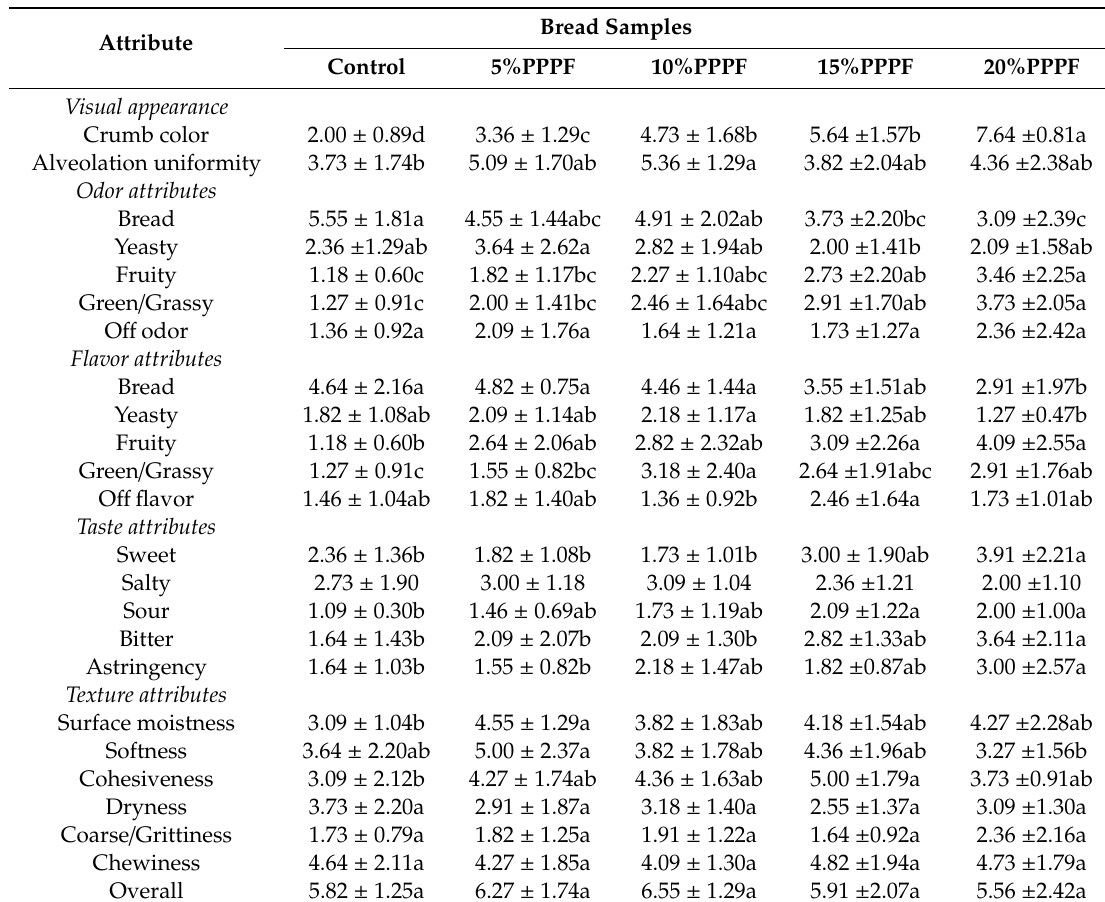
Table 8. Sensory profile of bread